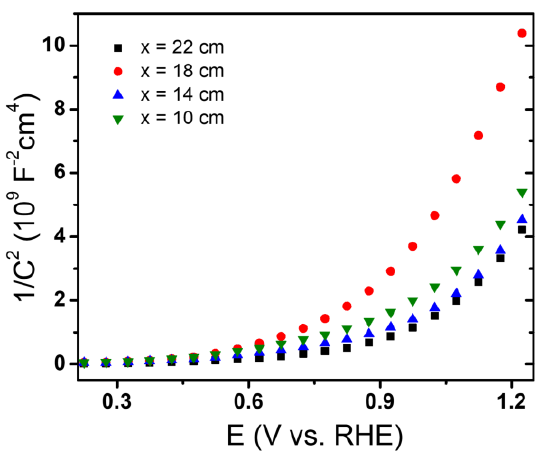
Figure 7. Mott–Schottky diagrams registered in NaOH 1 M, at 1 kHz. The diagrams correspond to Figure 7. Mott – Schottky diagrams registered in NaOH 1 M, at 1 kHz. The diagrams correspond to samples prepared at the positions of 10, 14, 18, and 22 samples prepared at the positions of 10, 14, 18, and 22 cm.